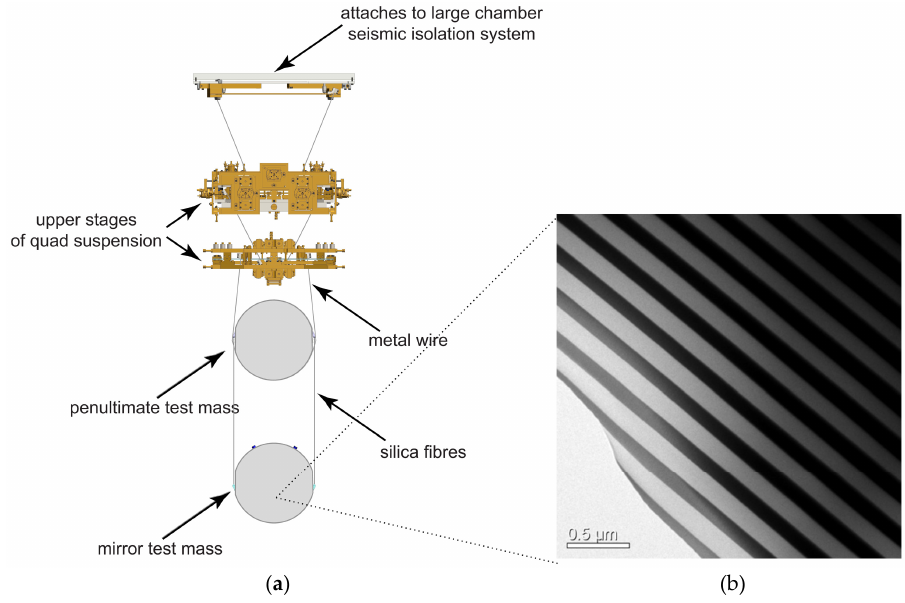
Figure 2. ( a ) CAD rendering of the Advanced LIGO mirror suspension; ( b ) SEM image of an ion beam ‐ sputtered λ /4 multilayer stack of SiO 2 (light) and TiO 2 doped Ta 2 O 5 (dark) designed for high ‐ reflectivity at 1064 nm. Note the mirror coating is deposited on the front surface of the mirror test mass.